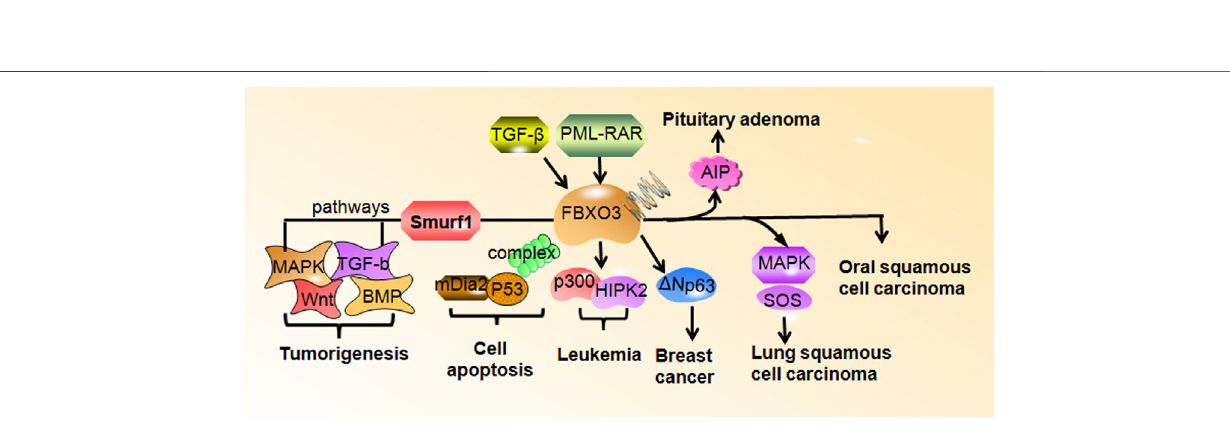
FIGURE2| FBXO3regulatesdownstreamtargetsinhumancancers.FBXO3targetsnumerousgenestoparticipateintumorigenesisandcellapoptosis.FBXO3is regulated by TGF- β and PML-RAR. The high expression of FBXO3 is frequent in rheumatoid arthritis, leukemia, pituitary adenoma, oral squamous cell carcinoma.